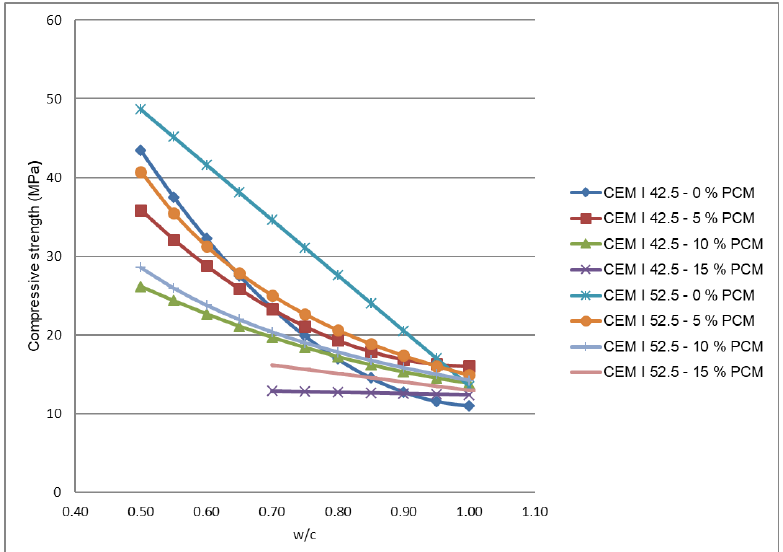
Figure 14. Compressive strengths in PX27 mortar mixtures. The flexural strength results for PX27 are reproduced in Figure 15. Each point corresponds to the mean value of three measurements, while 0.12 MPa maximum standard deviation was gained for w/c = 1, 10% PCM content and CEM I 52.5 R. As it is observed, using until 5% of PCM does not cause a significant lowering of strength. In contrast, the addition of 10% and 15% of PCM causes the reduction of flexural strength by half.